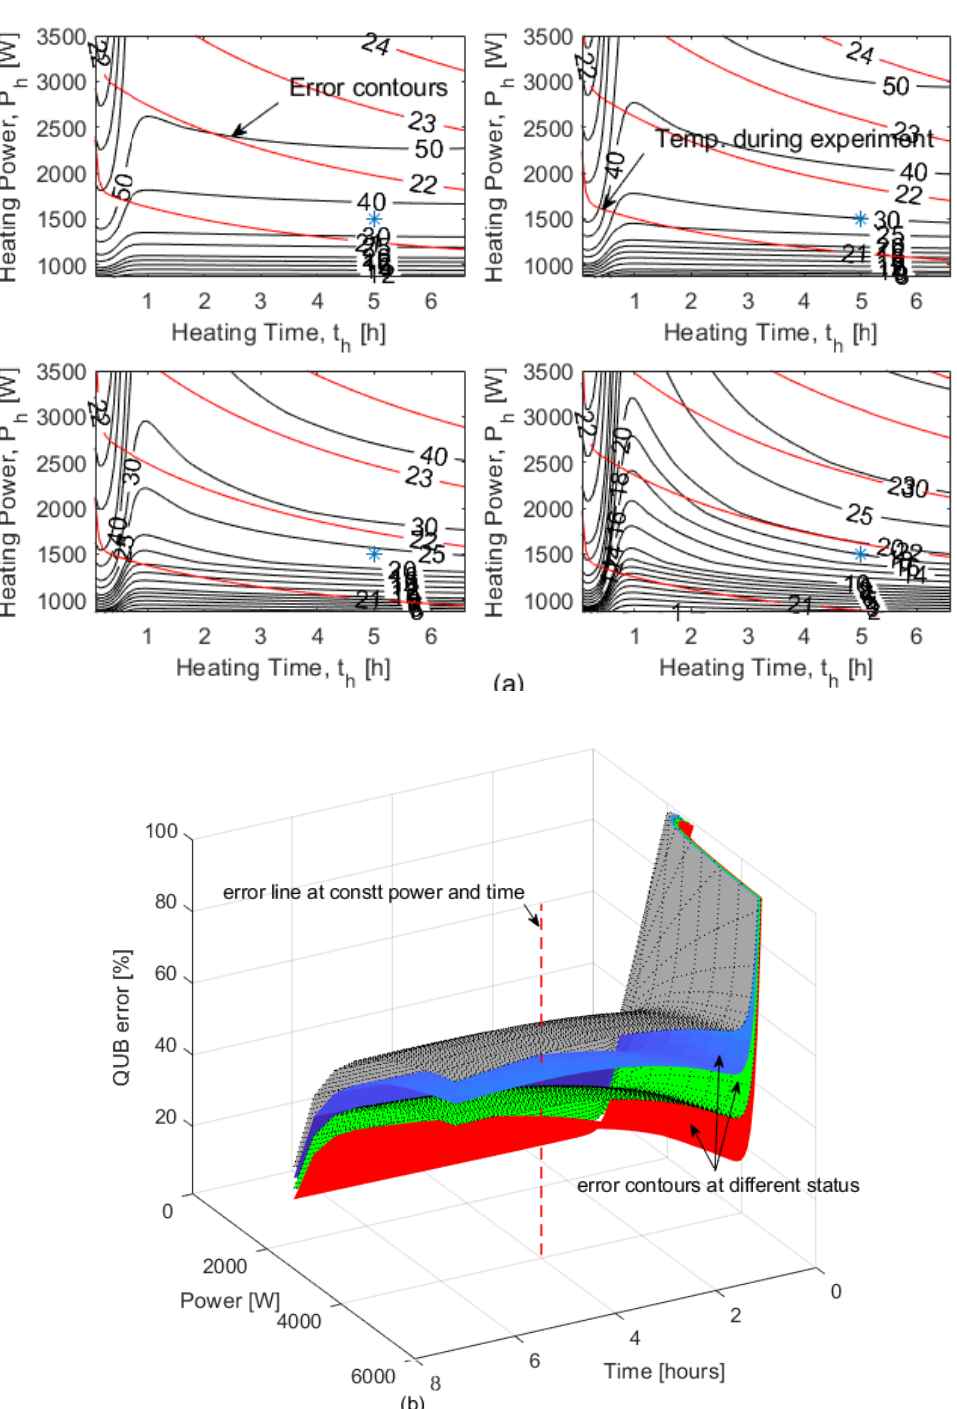
Figure 6. ( a ) Four QUB experiments performed at di ff erent initial states but same time duration (5 h) and power (1500 W). Blue asterisks show the error of QUB experiment at the given time and power (i) top left panel 35% error, (ii) top right panel 30% error, (iii) bottom left panel 24% error and (iv) bottom right panel 12% error. The black lines are constant error contour lines and red lines the maximum indoor temperature achieved during the QUB experiment. The blue asterisk shows the error ( b ) The same experiments as in ( a ) but with error curves shown in 3D (errors shown by the red vertical line).